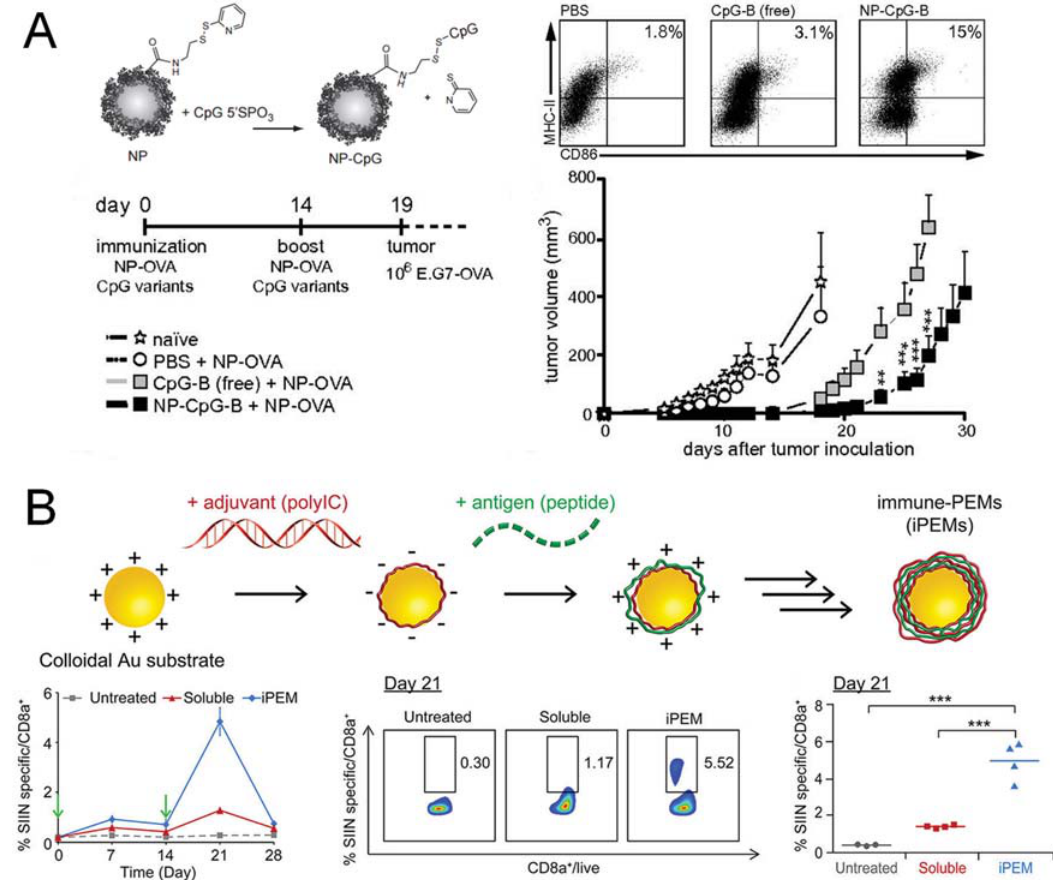
Figure 3. Co-delivery of antigens and adjuvants by nanoparticles. ( A ) TLR9 agonist CpG was conjugated on the surface of polymeric nanoparticles via disulfide exchange. The particulate adjuvant improved DC activation in vitro as well as prophylactic efficacy against tumor in vivo , compared with the soluble CpG; ( B ) TLR3 agonist poly I:C and an antigen peptide were complexed onto gold nanoparticles via electrostatic interactions, and elicited more antigen-specific CD8 + T cells compared with the soluble vaccine. Panel ( A ) reproduced with permission [68]; Panel ( B ) reproduced with permission